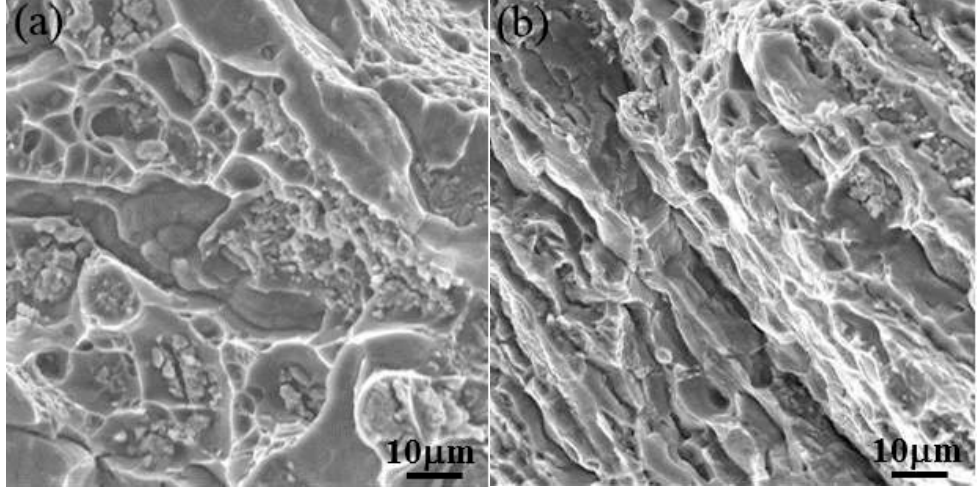
Figure 10. SEM micrographs showing fracture surfaces of the over ‐ aged 7050 aluminum alloy along different directions ( a ) the rolling direction (RD); ( b ) the long ‐ transverse direction (LT).